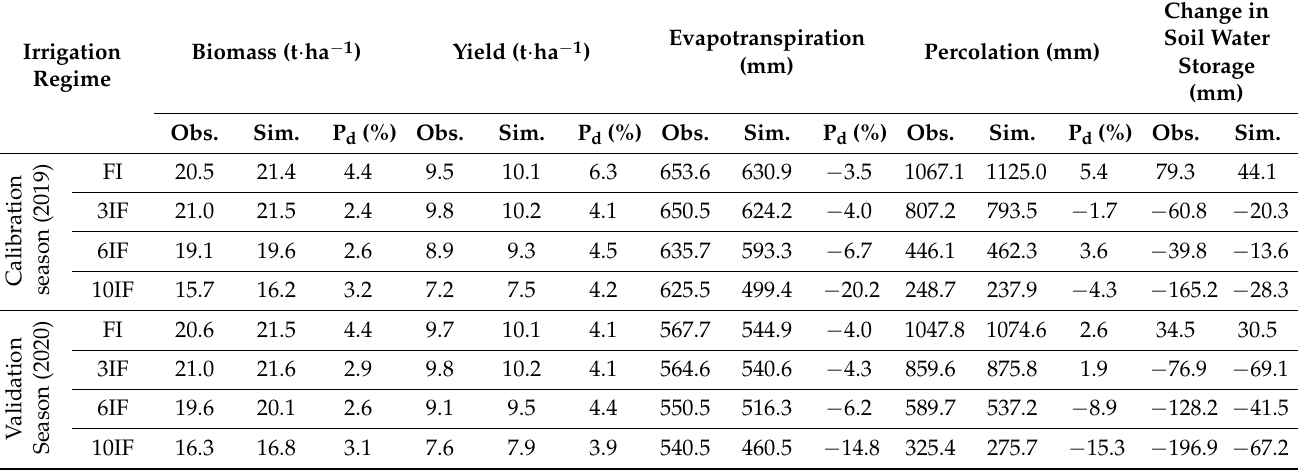
Table 5. Percent deviation of rice biomass, yield, and in-field water balance components during 2019 and